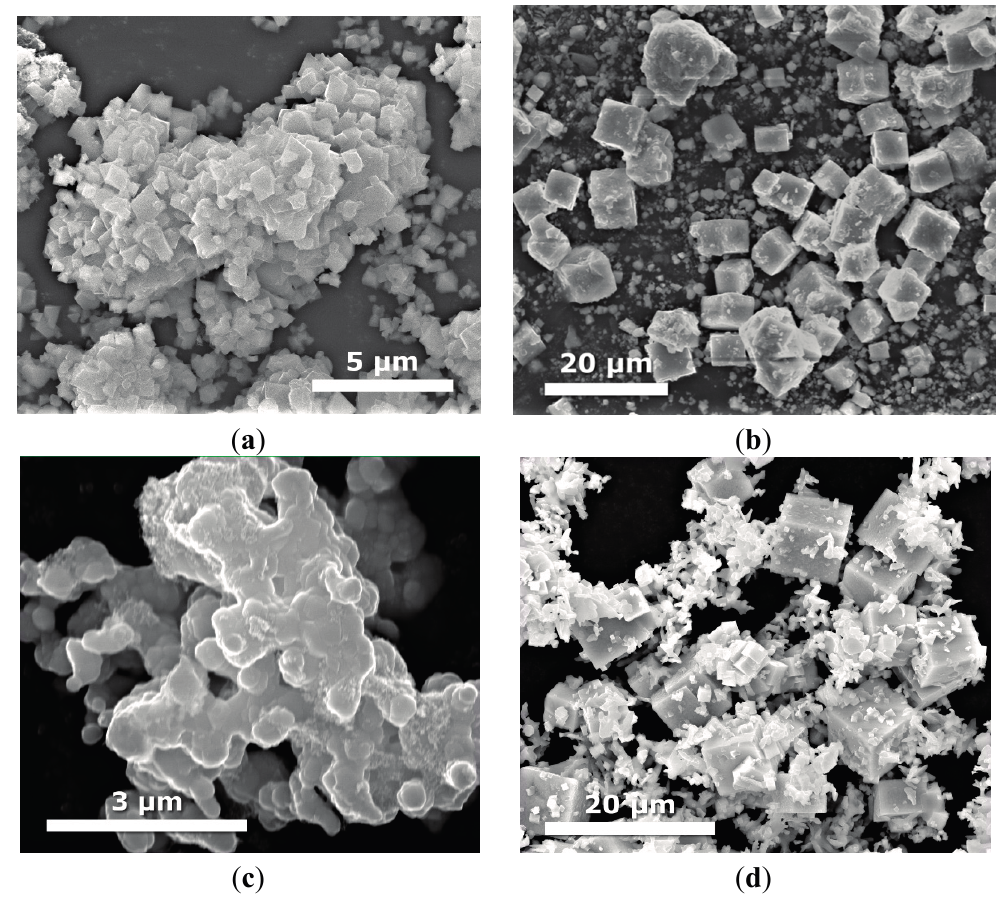
Figure 5. SEM images of ternary KTaO 3 -CdS-MoS 2 composites obtained with different molar ratio and using two different preparation route: ( a ) KTaO 3 -CdS-MoS 2 (10:1:1) obtained by solvothermal mixed solutions (sample KTaO 3 -CdS-MoS 2 10-1-1 _ MS); ( b ) KTaO 3 -CdS-MoS 2 (10:1:1) obtained by calcination of single previously synthesized semiconductors (sample KTaO 3 -CdS-MoS 2 10-1-1 _ C); ( c ) KTaO 3 -CdS-MoS 2 (10:5:1) obtained by solvothermal mixed solutions (sample KTaO 3 -CdS-MoS 2 10-5-1 _ MS); and ( d ) KTaO 3 -CdS-MoS 2 (10:5:1) obtained by calcination of single previously synthesized semiconductors (sample KTaO 3 -CdS-MoS 2 10-5-1 _